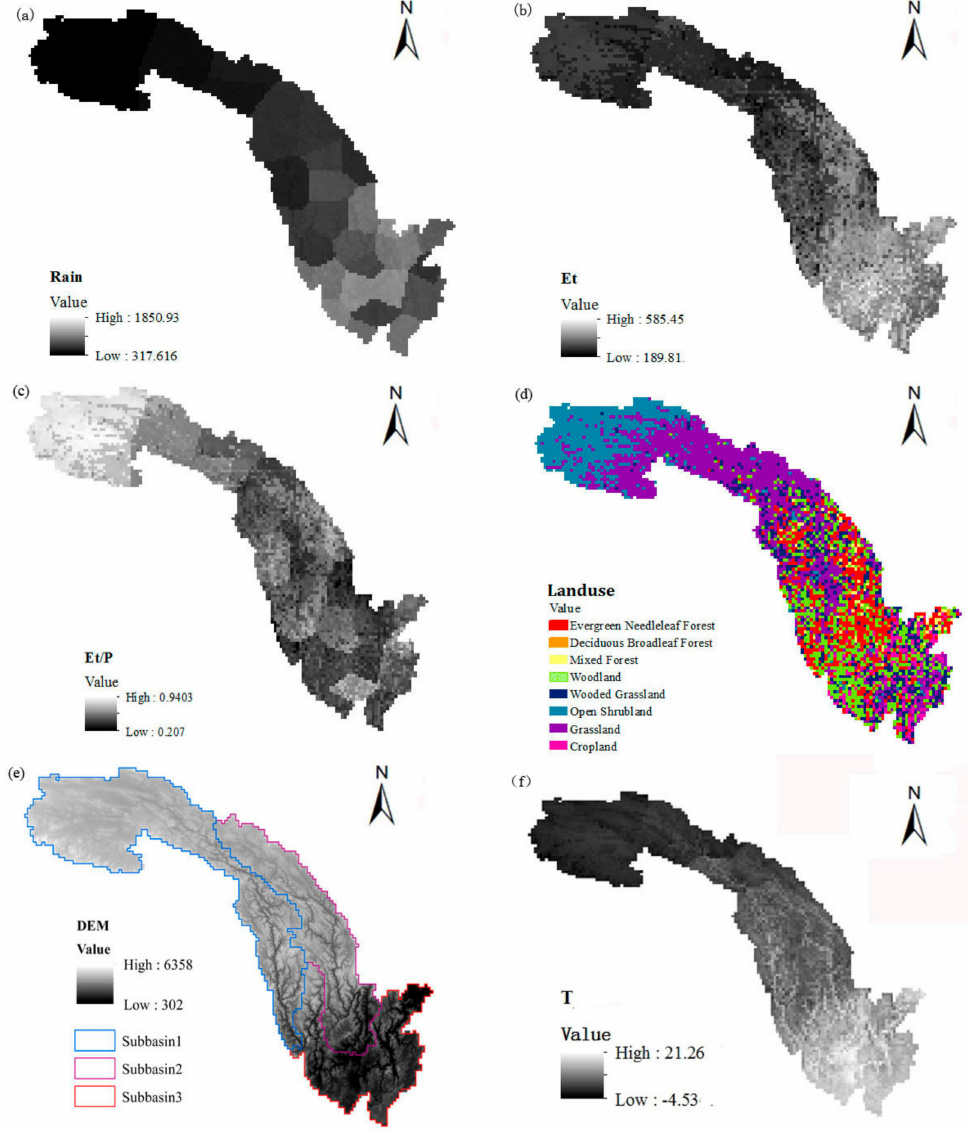
Figure 8. The spatial distribution of the mean annual precipitation ( a ), evapotranspiration ( b ), and fraction of evapotranspiration to precipitation ( c ), land cover ( d ), elevation ( e ), and mean annual temperatures ( f